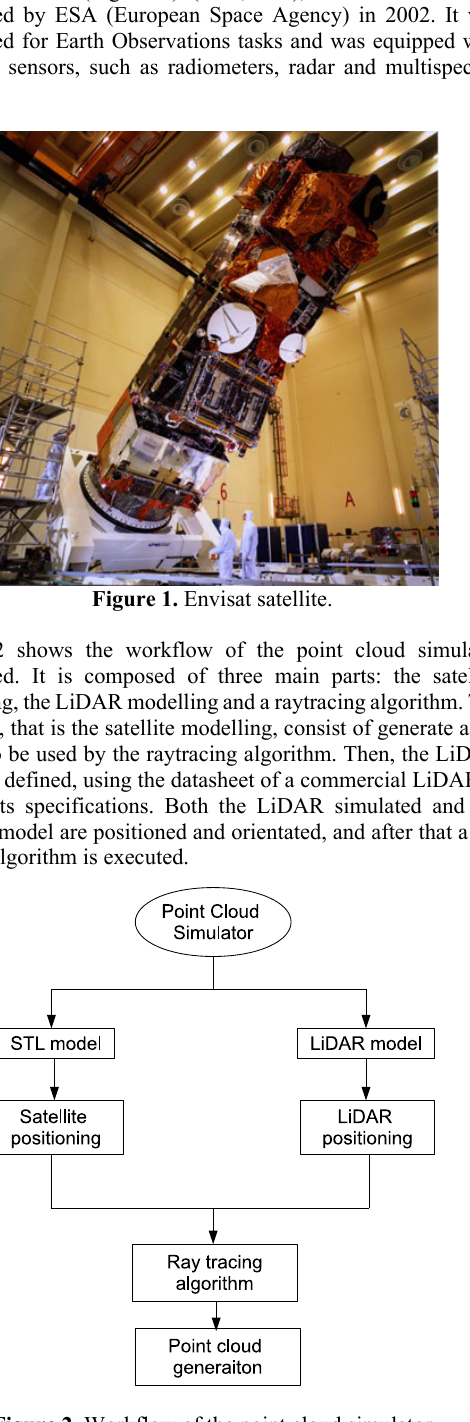
Figure 2. Workflow of the point cloud simulator